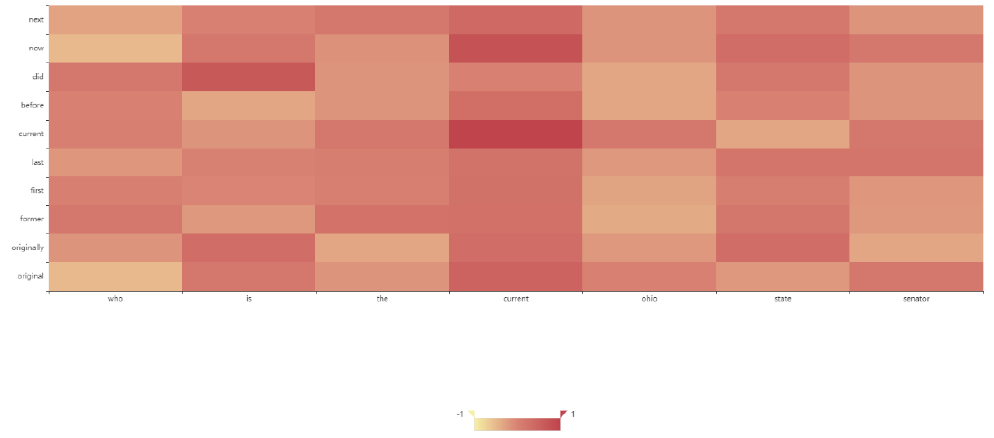
Figure 4. Attention heatmap generated by the temporal attention module.